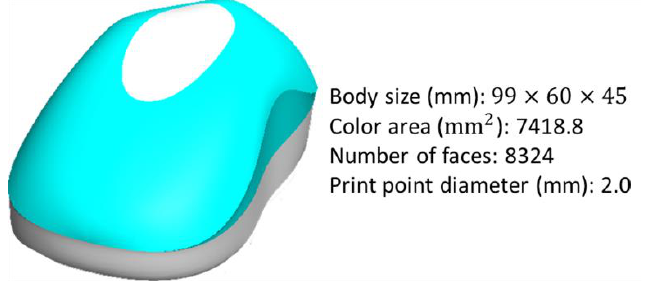
Figure 14. The mouse model.